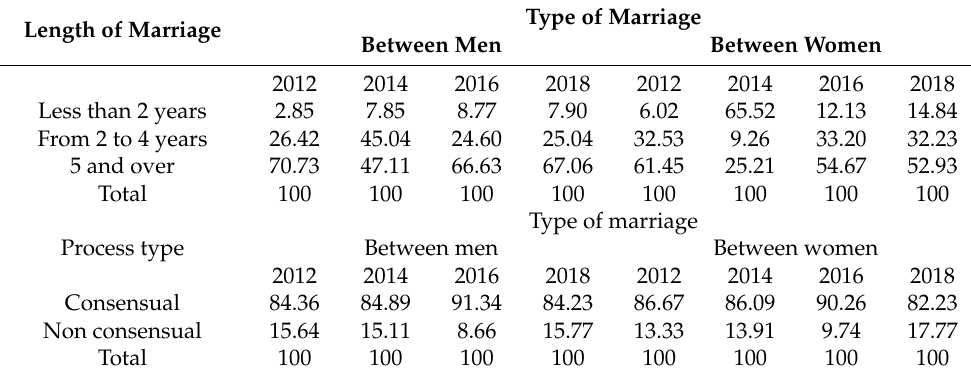
Table 3. Duration of same-sex marriage and type of divorce (%).